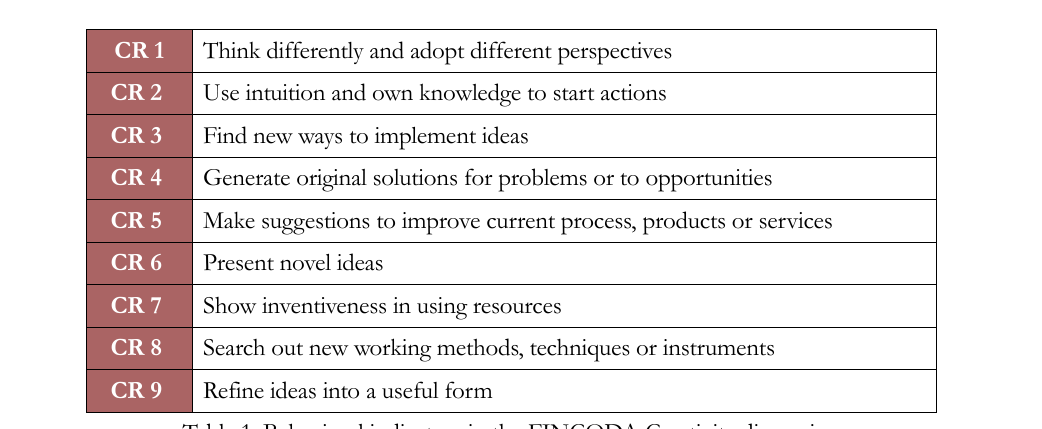
Table 1. Behavioral indicators in the FINCODA Creativity dimension